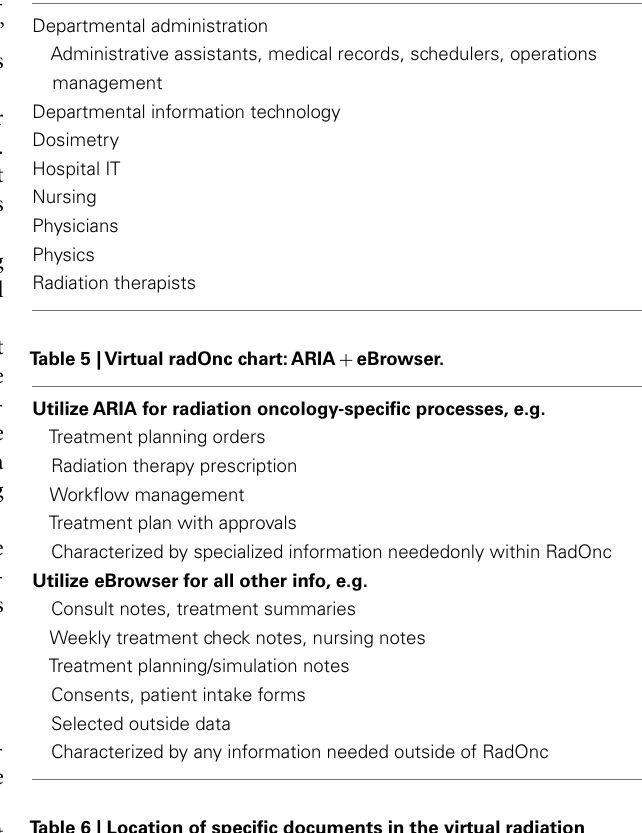
Table 4 | Composition of radiation oncology EMR team.